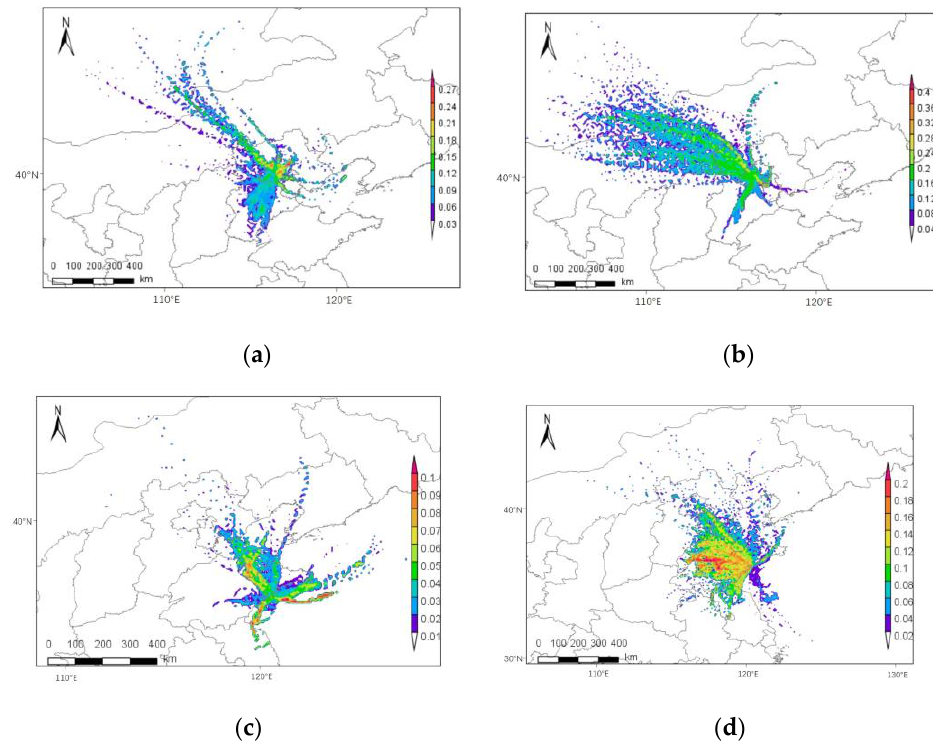
Figure 4. Distribution of concentration-weighted trajectory method analysis in autumn (September, October, November) and winter (December) in Beijing ( a , b ) and Qingdao ( c , d ), respectively. In autumn, the WCWT area in Beijing included central and northern Beijing, northern Hebei province, central Inner Mongolia, and northern Tianjin (Figure 4a). Among them, the WCWT value for Cr(VI) exceeds 0.21 ng/m 3 in some parts of northern and central Bei- jing. In winter, the high-value areas of WCWT and PSCF were notably different (Figure 4b). Southern Beijing and northern Tianjin have a primary contribution to the Cr(VI) pol- lution. In addition, the distribution areas of local medium contribution in Beijing had sharply increased. The results indicate that the conditions of the stable boundary layer and the influence of fossil fuel burning led to a crucial contribution of Cr(VI) pollution in local sources in winter [50]. The WCWT area in autumn in Qingdao demonstrated that the Cr(VI) showed higher levels in northern Shandong province and the southern Bohai Sea (Figure 4c). The ocean air masses from the south and northeast with the WCWT value for Cr(VI) exceeding 0.09 ng/m 3 were deemed as the major contributors in autumn. In winter, the WCWT contribu- tion area was similar to the potential source area of PSCF, mainly in most areas of Shan- dong province (Figure 4d). The central part of Shandong province had the highest WCWT value (>0.16 ng/m 3 ). Zibo and Jinan, which are located in the central part of Shandong Province, have many petrochemical and steel industries, which may have contributed to the Cr(VI) pollution in Qingdao; meanwhile, the emission of local petrochemical enter- prises in Qingdao also contributes to some pollution [51]. 3.3. The Ratio of Cr(VI)/Cr in Ambient PM 2.5 Many studies showed that the ratio of Cr(VI)/Cr in ambient air varied from 10% to 70% [52 – 54]. Many domestic studies on the regional pollution concentrations of airborne Cr(VI) are estimated by referring to the ratio of Cr(VI) to total Cr in dust (0.13) in China [30]. However, the estimation of this method needs to be verified by the on-site observa- tion experiments. In this study, the ratio of Cr(VI)/Cr in atmospheric PM 2.5 was calculated by measuring both Cr(VI) and total Cr in Beijing and Qingdao simultaneously. During the sampling period, the daily variation of the ratio of Cr(VI)/Cr are shown in Figure 5. The average value of Cr(VI)/Cr is (0.0623 ± 0.0969), which is about one half of the ratio (0.13) in dust cited in other studies [55,56]. In Beijing, the ratio of Cr(VI)/Cr was (0.076 ± 0.104), with the range of (0.004 – 0.506) during the sampling periods. In Qingdao, the average values were (0.041 ± 0.039), with the range of (0.0003 – 0.244). The ratio in the above two cities were about 41.53% lower than the ratio in dust. The results indicate that the percentage of Cr(VI) in the total Cr in atmospheric PM 2.5 is lower than that in dust. Thus, the main oxi- dation state of Cr in atmospheric fine particles may be Cr(III), as the concentration of Cr(III) is significantly higher than Cr(VI).